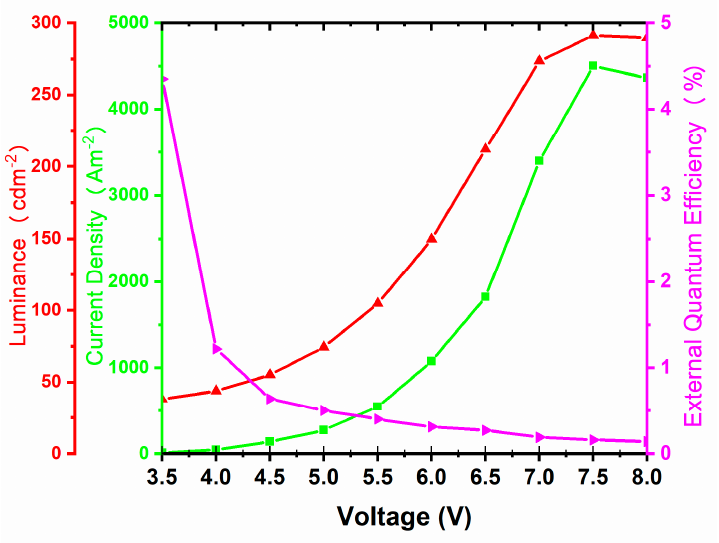
Figure 7. Performance plots for the OLED prototype with compound B as the emissive layer. Structure of the device is shown in Figure 6A.